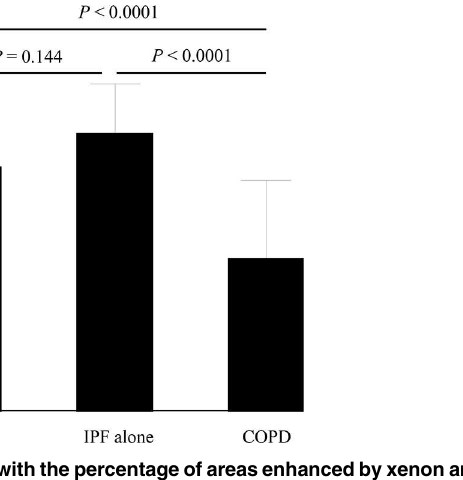
Table 2. Correlation coefficients for relationships between the percentage of areasenhanced by Xenon and pulmonary function parameters in the whole patients (n = 80). Variable